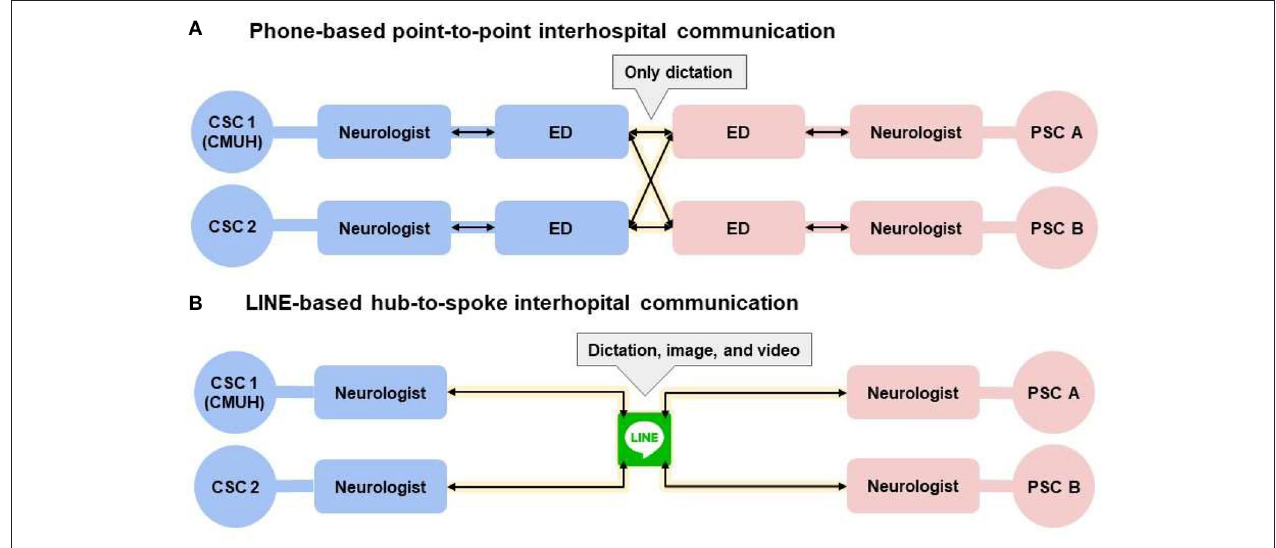
FIGURE 4 | The way of communication changed by smartphone application, LINE. (A) Indicates the original way of communication. Doctor or nurse practitioner in each hospital needed to communicate by phone call. (B) Indicates the novel way of communication. All the related staff could see the message at the same time, including the dictation, image, or video. We put the circle of CSC2, because sometimes our hospital could not receive the transfer patients. For example, we are doing another thrombectomy or stoke activations in two different primary stroke centers. We invited the neurologists in CSC2 to let them know the need of